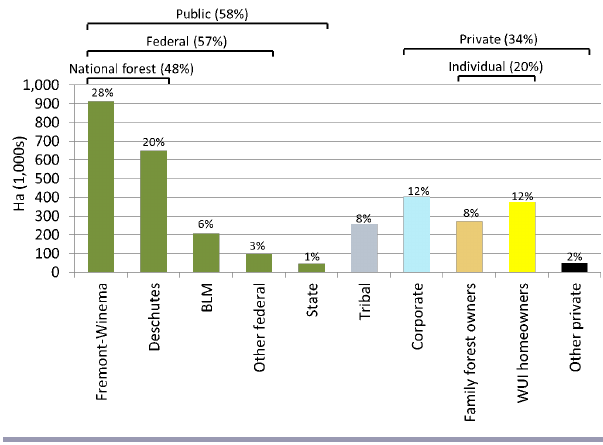
Fig. 3 . Distribution of study area land among landscape actors (BLM: Bureau of Land Management; WUI: wildland–urban